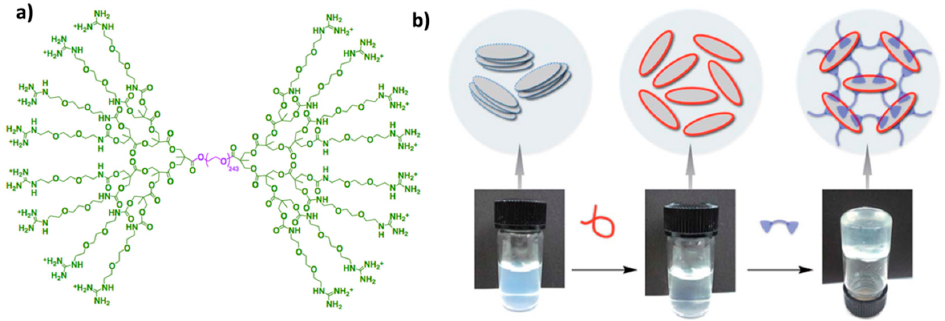
Figure 25. ( a ) DLD dendron-polymer conjugate with a linear PEG segment and G3 polyester dendrons displaying guanidinium ions; ( b ) dispersion of clay nanosheets by sodium polyacrylate and the addition of the positively-charged DLD with the G3 polyester dendron bearing guanidinium ions for crosslinking of clay nanosheets. Adapted by permission from Macmillan Publishers Ltd: Nature [57], Copyright © 2010.